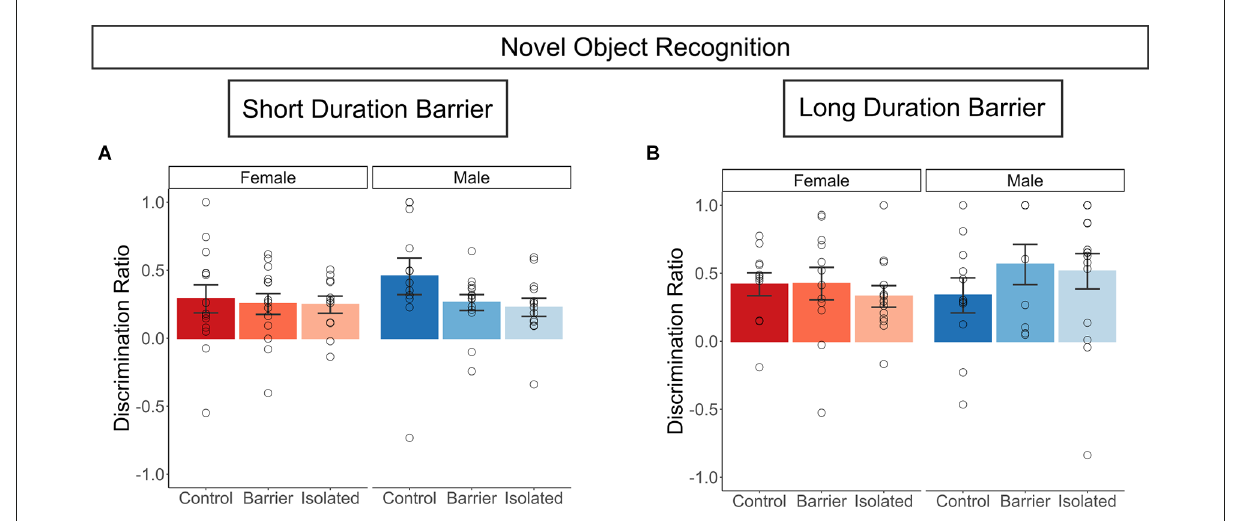
FIGURE3 Juvenile play deprivation has no effect on novel object memory in adulthood. Discrimination ratio ( A,B , calculated as the time spent investigating the novel object minus that of the familiar object, divided by the total time spent investigating either object), in the short and long duration barrier studies, respectively, at P60. Bars indicate group means ± SEM, and open circles represent data from individual rats. n = 9–15 per group.